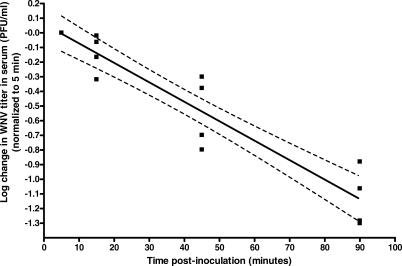
Clearance of WNV from the Serum following Intravenous InoculationMice (n = 4) were inoculated intravenously with 105 PFU and serum samples taken at various times PI. For each mouse, WNV titers in the serum were normalized to the 5-min serum titer and reported as log change in WNV serum titer. Solid line indicates best-fit linear regression (R2 = 0.90, p < 0.0001); dashed lines indicate 95% confidence band for regression line.